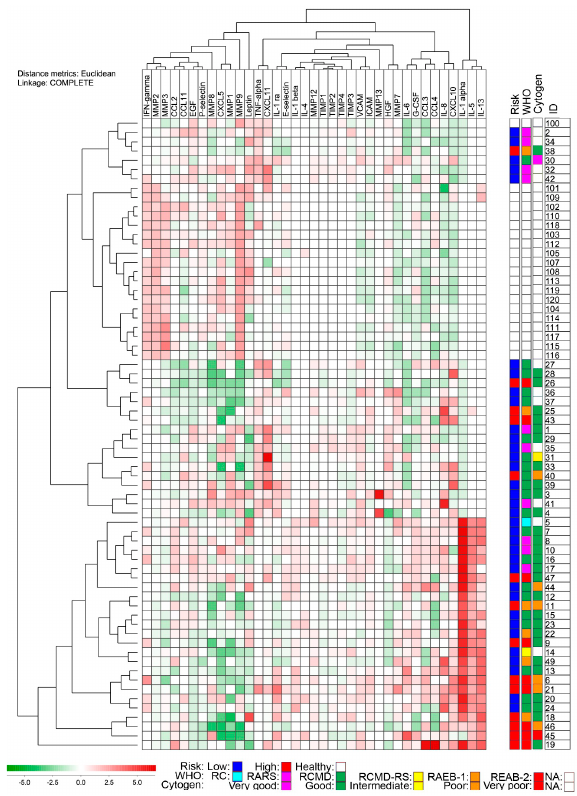
Figure 2. Unsupervised hierarchical clustering of MDS patients and healthy controls. Parameters where 10 or more sample values were above lowest detectable value were included in the clustering analysis. Parameters closely correlated to platelet counts were also excluded from cluster analysis (cluster of differentiation 40 ligand (CD40L), CCL5, vascular endothelial growth factor (VEGF), and thrombopoietin (TPO)). All values were median variance standardized and log(2)-transformed prior to Euclidian distance clustering. Red-to-green gradient (see lower left part of the figure) represents expression levels above or below the median serum levels for each individual parameter, respectively. The classification systems that are used in the right part of the figure with regard to low/high risk myelodysplastic syndromes (MDS) based on international prognostic scoring system (IPSS) (Risk), World Health Organization classification (WHO), and cytogenetic abnormalities (Cytogen) are also explained in the lower part of the figure. Risk: low-risk MDS patients—blue, high-risk MDS patients—red, healthy controls—white. WHO subclasses: refractory cytopenia (RC)—turquoise, refractory anemia with ring sideroblasts (RARS)—magenta, refractory cytopenia with multilineage dysplasia (RCMD)—green, refractory cytopenia with multilineage dysplasia and ring sideroblasts (RCMD-RS)—yellow, refractory anemia with excess blasts-1 (RAEB-1)—orange, RAEB-2—red, data not available (NA)—white. Cytogenetics: very good—magenta, good—green, intermediate—yellow, poor—orange, very poor—red,